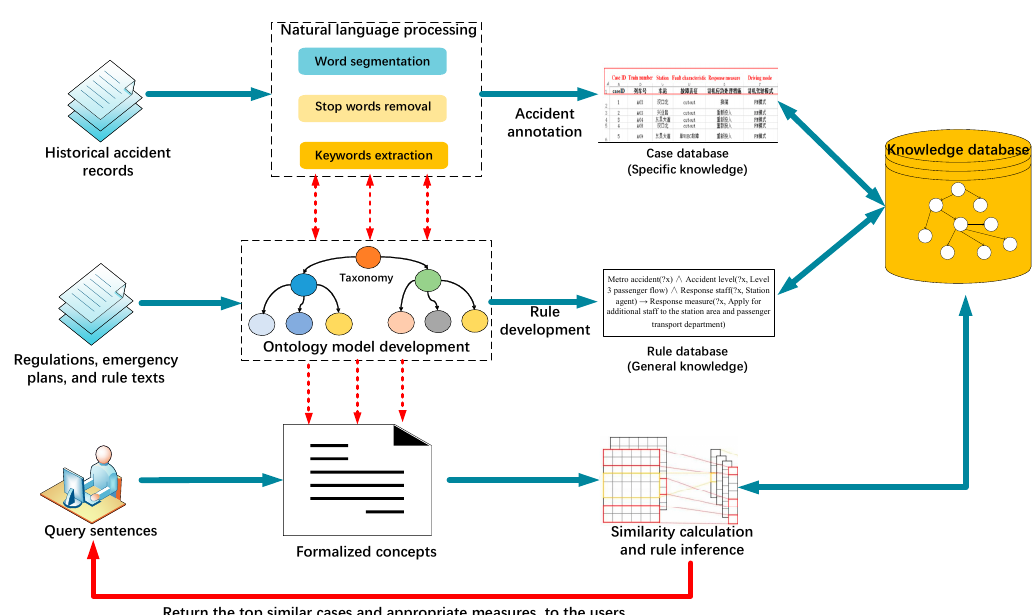
Figure 2. Workflow of knowledge retrieval for supporting decision-making.